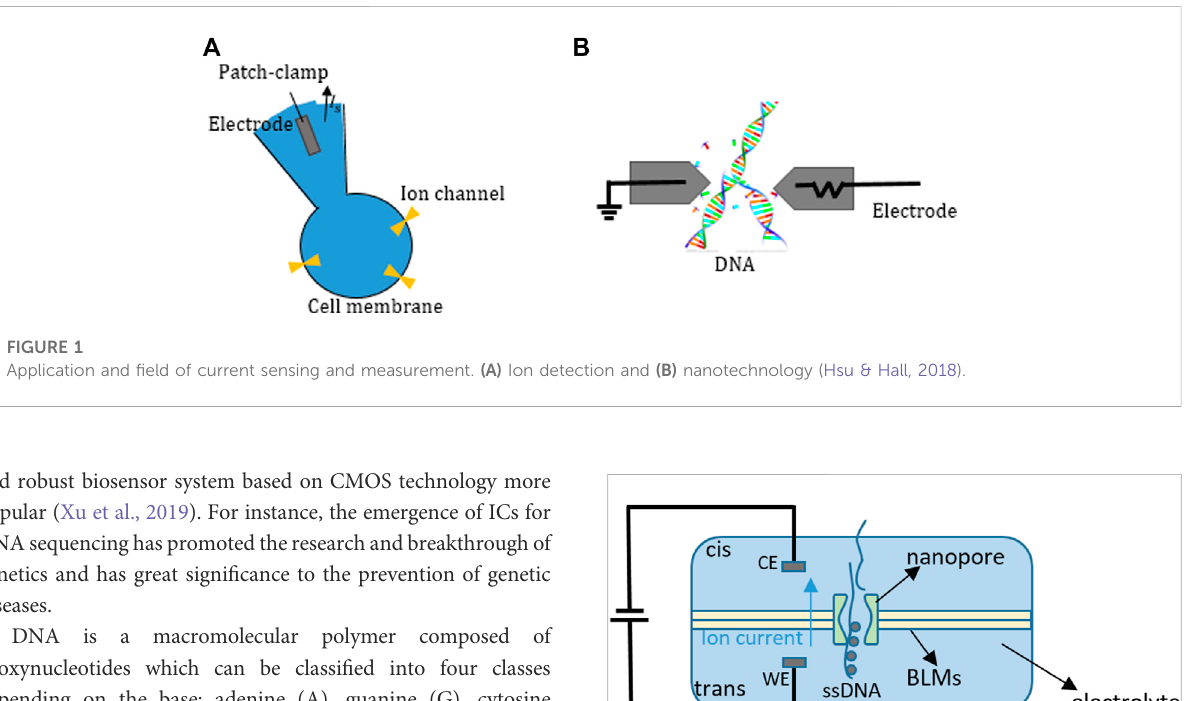
FIGURE 2 Process of nanopore-based DNA sequencing ( ‘ WE ’ represents ‘ work electrode ’ and ‘ CE ’ represents ‘ common electrode ’ ) (Dong et al.,